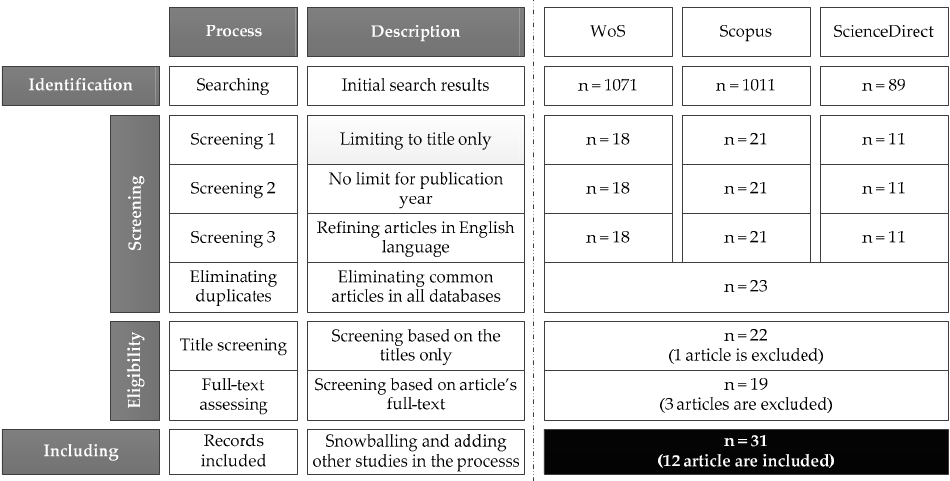
Figure 3. PRISMA flow diagram .